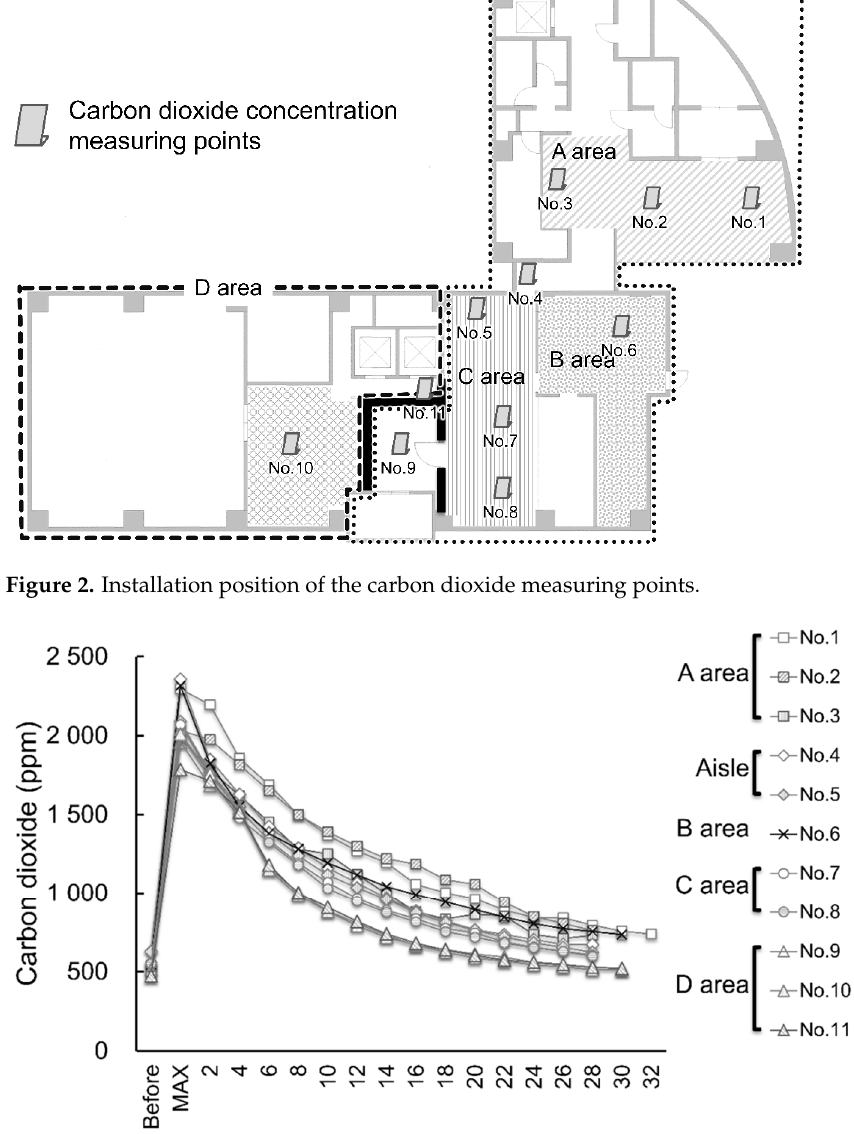
Figure 2. Installation position of the carbon dioxide measuring points.